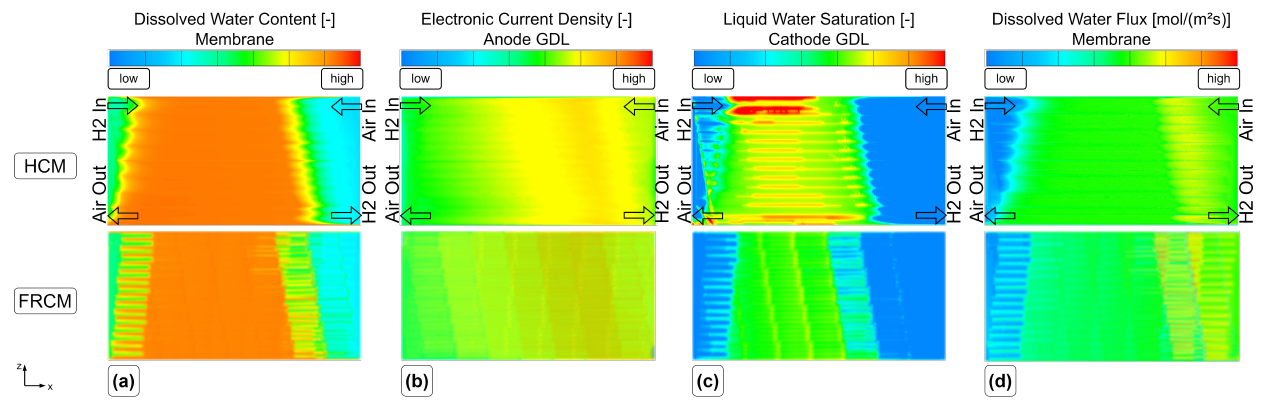
Figure 8. Comparison of quantities of interest with HCM and FRCM. For each of the results, the same min. and max. values of the color bar were set. ( a ) Dissolved water content of the membrane. ( b ) Electronic current density in anode GDL. ( c ) Liquid water saturation in cathode GDL. ( d ) Dissolved water flux in the